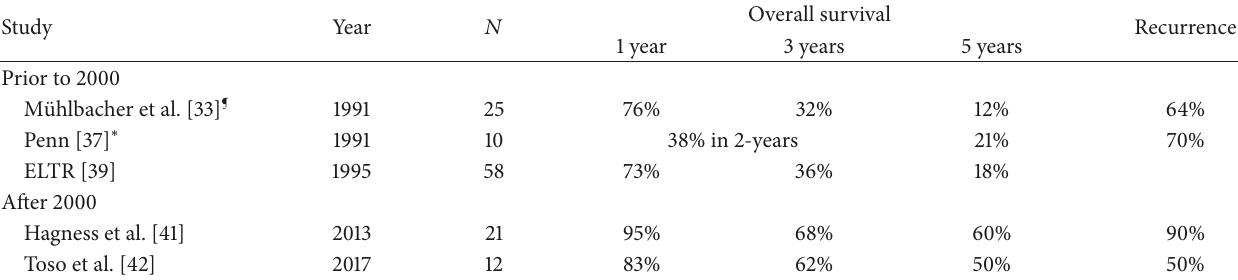
Table 1: Published series on LT for